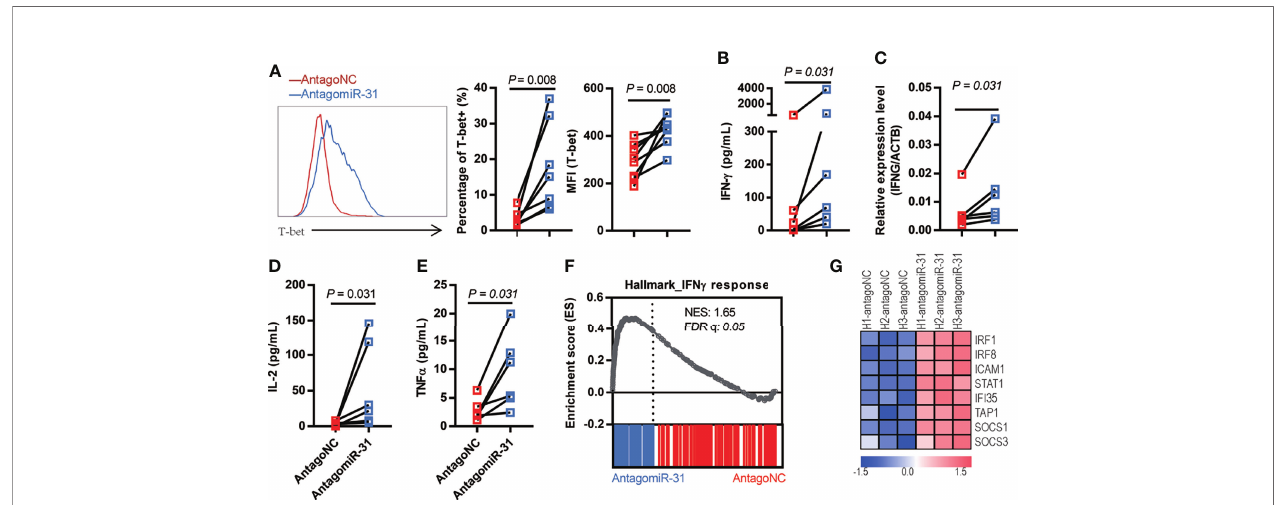
FIGURE 3 | Loss of miR-31 drives the Th1-biased response of naïve CD4+ T cells. (A) Effect of antagomiR-31 versus antagoNC treatment on the T-bet expression of naïve CD4+ T cells from healthy donors. Flow cytometry analysis was performed at 48hrs post treatment, shown are representative FACS plot (left), percentages of T-bet+ cells (middle), and MFI of T-bet (right). The relative fold changes in T-bet+ cell percentage and MFI of T-bet were 5.46 and 1.45 respectively (n = 8). (B – E) Supernatants from antagomiR-31- and antagoNC-treated naïve CD4+ T cells (n = 6) were collected at 48hrs post treatment for determination of IFN- g (B) , fold change = 7.81), IL-2 (D) fold change = 14.68) and TNF (E) fold change = 3.42) using cytometric bead array (n = 6). The cells were also harvested for determination of IFN- g mRNA levels by quantitative RT-PCR [ (C) , fold change= 2.08]. (F) GSEA plot of enrichment in IFN- g response gene signature in antagomiR-31-treated naïve CD4+ T cells. (G) Heatmap of the representative core enrichment genes involved in IFN- g